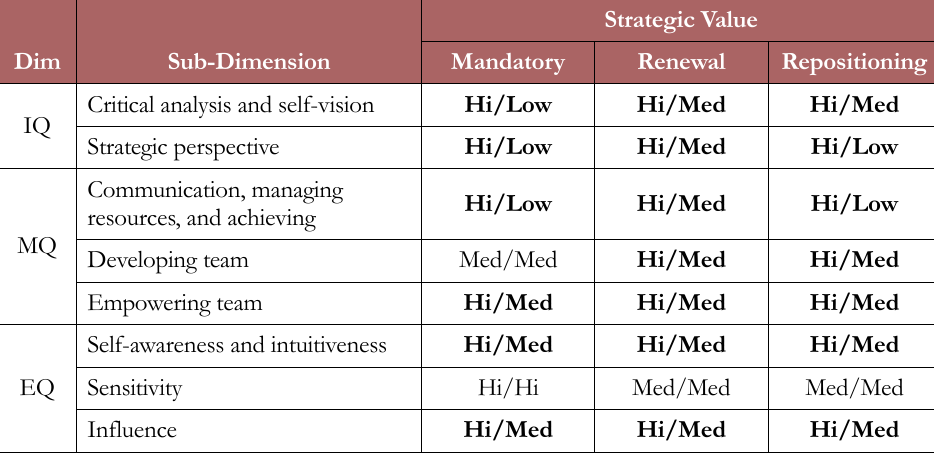
Table 13. Project Strategic Value as a Non-Moderating